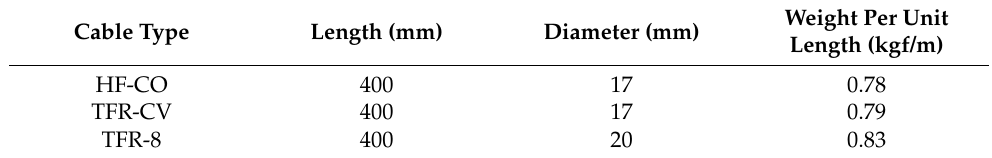
Table 4. Dimensions of power cable specimen.